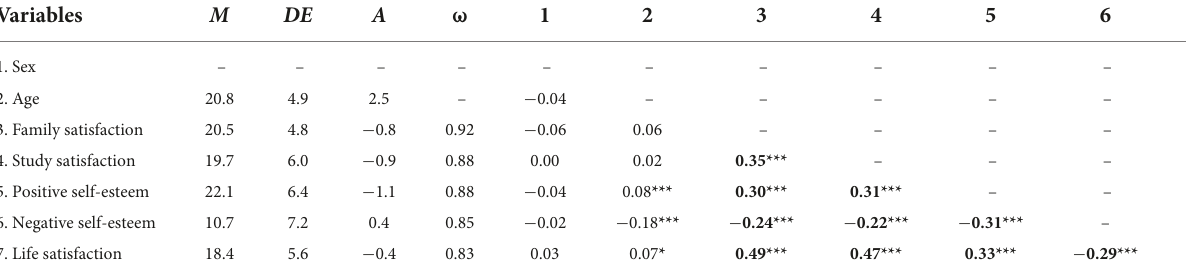
TABLE 1 Descriptive statistics, internal consistencies, and correlations of study variables.